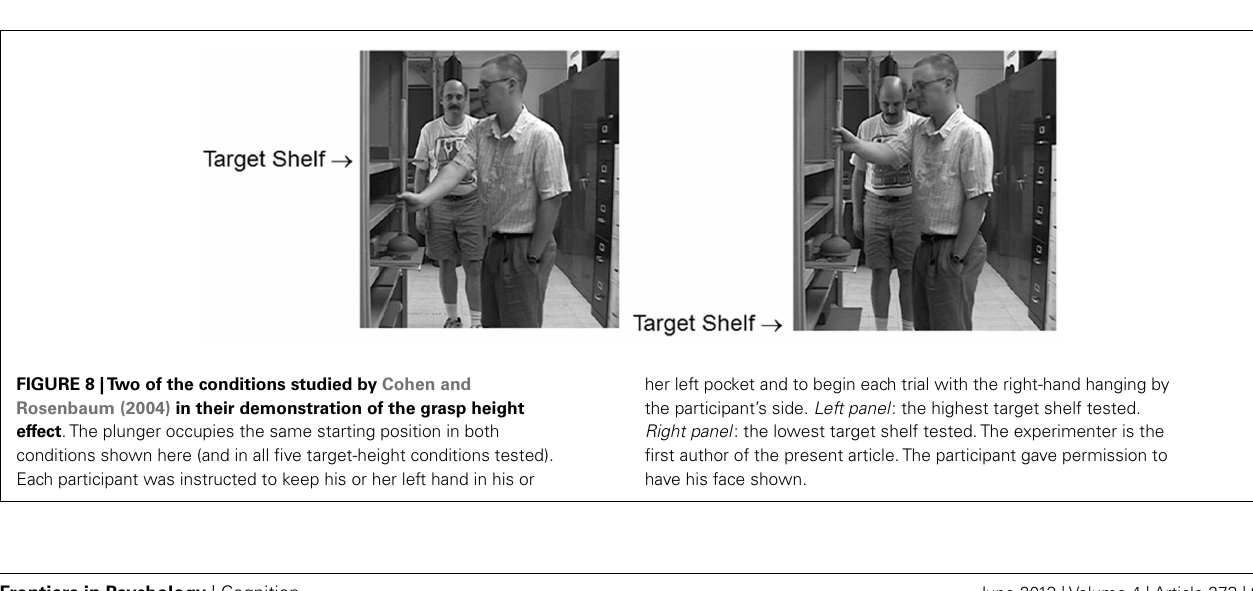
her left pocket and to begin each trial with the right-hand hanging by the participant’s side. Left panel : the highest target shelf tested. Right panel : the lowest target shelf tested.The experimenter is the first author of the present article.The participant gave permission to have his face